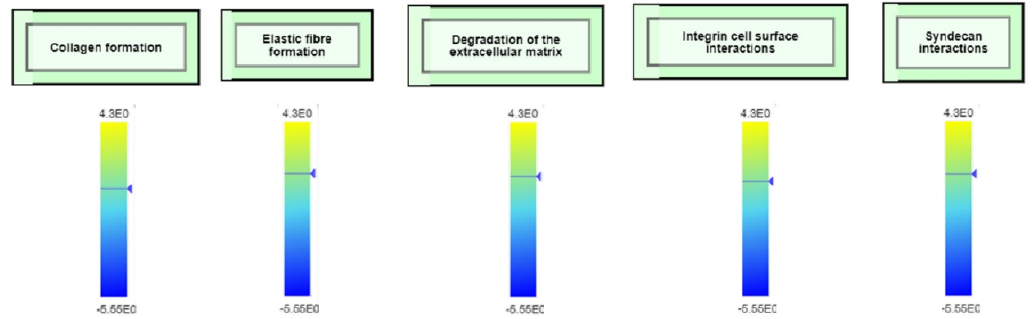
Figure 6. Enrichment of extracellular matrix (ECM)-related pathways in the HF/SD versus HF/RD group. KEGG analysis by STRING indicate an enrichment of pathways related with ECM. Entities are colored according to the expression scales when the HF/SD group is compared with the HF/RD group. Yellowish tones indicate positive fold-changes and bluish tones refer to negative fold-changes. The entities are partly colored as per the number of molecules of the pathway that were in the submitted list. The median for the pathway is flagged.